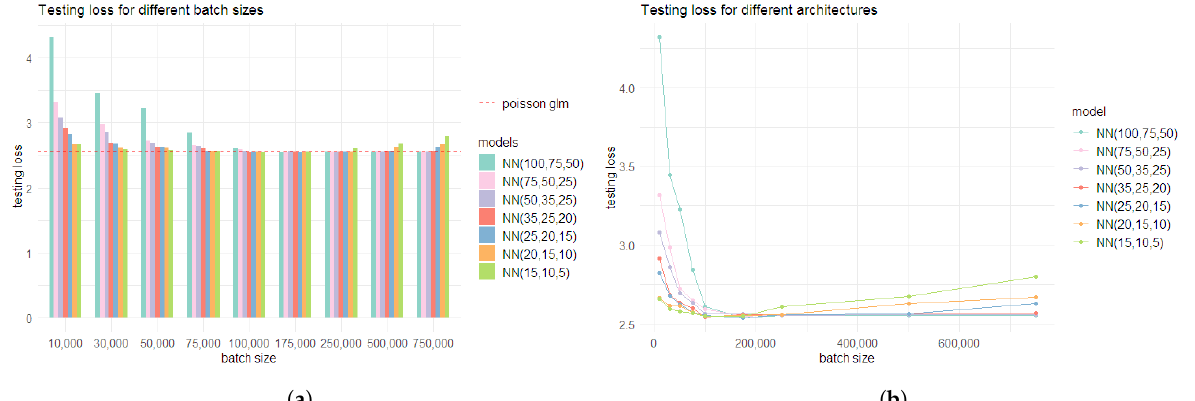
Figure 6. Performance of the different models under the initial step of approach 1, under varying batch sizes: ( a ) testing loss for the Poisson NN models under different architectures. The red line shows the testing loss for the Poisson regression model; ( b ) change in the testing loss for the Poisson NN models under different architectures as the batch size